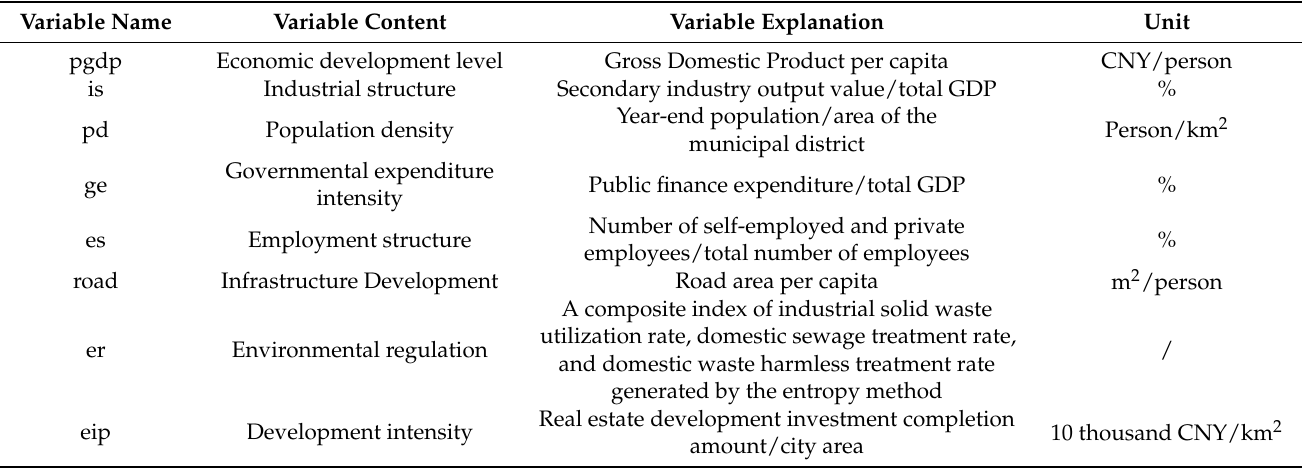
Table 2. Influencing indicators of the ULGUE.